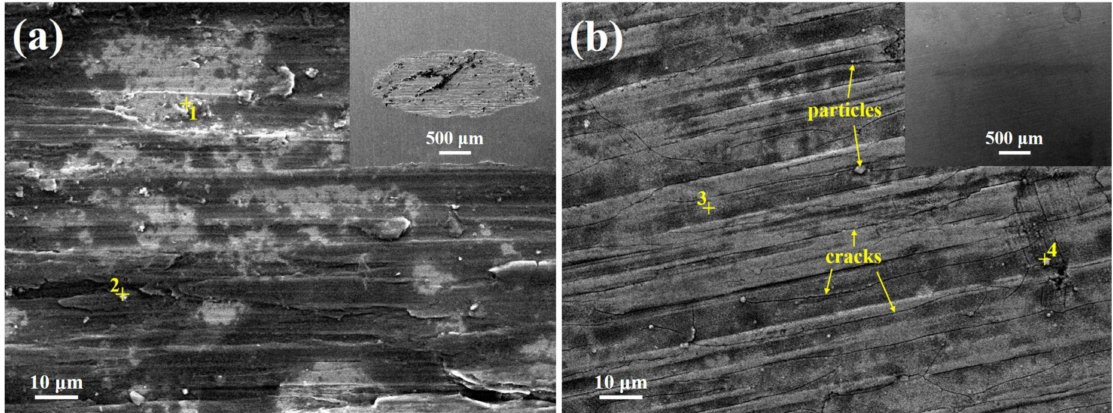
Figure 11. SEM micrographs of worn tracks and the select locations of corresponding EDS spectra for ( a ) as-deposited and ( b ) 600 ◦ C annealed Ni-Mo-W coatings, and the corresponding morphologies at low magnification are shown in insets of ( a , b ),